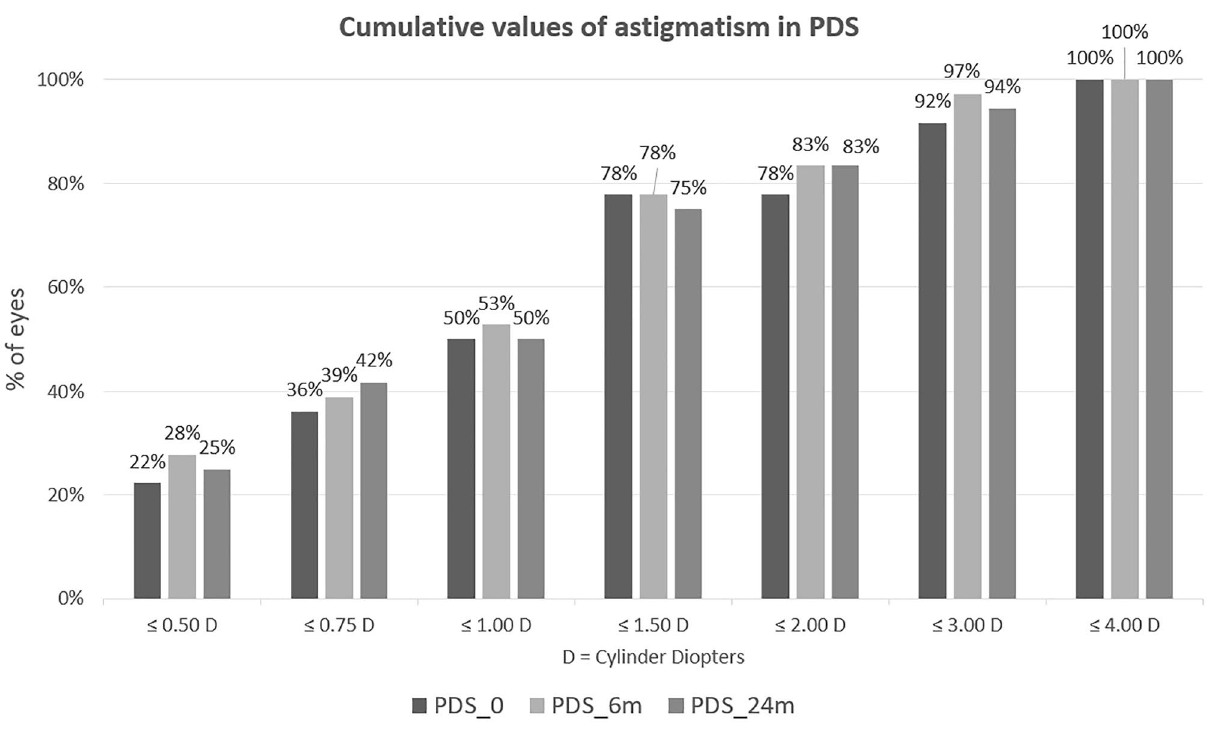
Figure 2. Cumulative astigmatism in